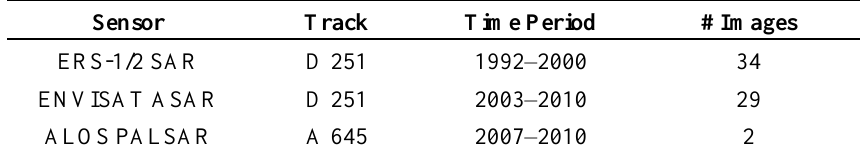
Table 2. Satellite SAR data considered in our study (A: ascending orbit; D: descending